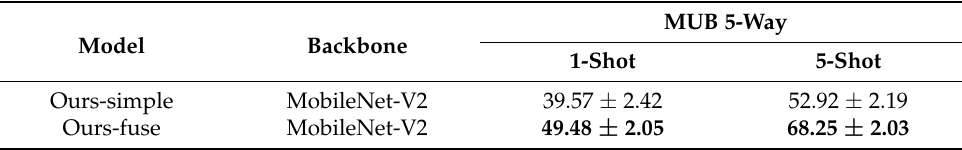
Table 3. We conduct experiments on the MUB dataset. Average meta-learning classification accuracies (%) with 95% confidence intervals on MUB meta-test splits.